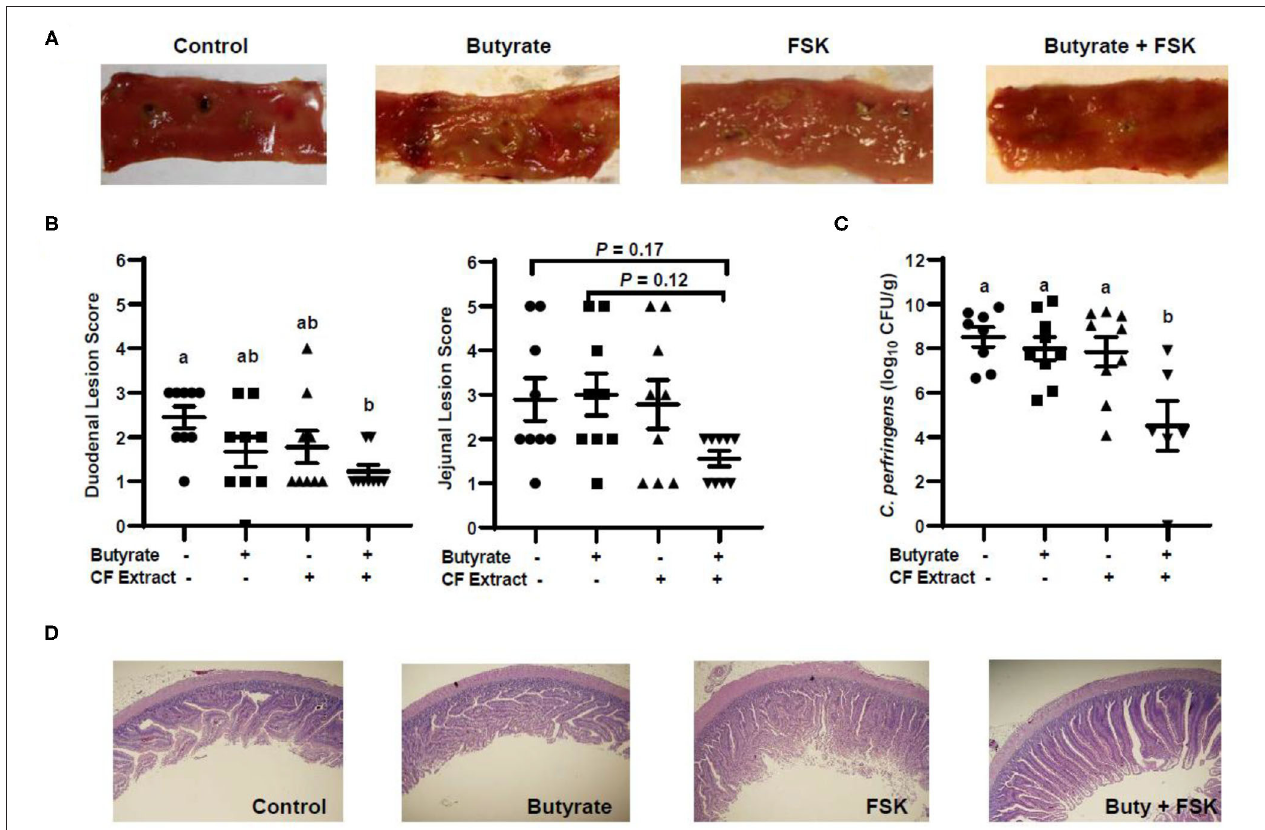
FIGURE 4 | Alleviation of necrotic enteritis in chickens by butyrate and FSK. Chickens were fed a basal diet supplemented with or without 1 g/kg of sodium butyrate, 5 mg/kg of 10% FSK-containing Coleus forskohlii plant extract, or the combination for 3 days prior to induction of necrotic enteritis. After 4 days of infection, intestinal lesions, bacterial titer, and histology were examined in the duodenum and jejunum of each chicken. (A) Representative lesions in the jejunum of each group. (B) The lesions in the duodenum and jejunum were scored and compared among different groups ( n = 9) 4 days post infection. (C) The titer of Clostridium perfringens in the jejunal contents of each animal. Statistical significance ( P < 0.05), denoted by non-common letters, was determined using one-way ANOVA and post-hoc Tukey’s test. Treatments with P < 0.20 were also indicated to show a trend. (D) Representative jejunal morphology of each group of